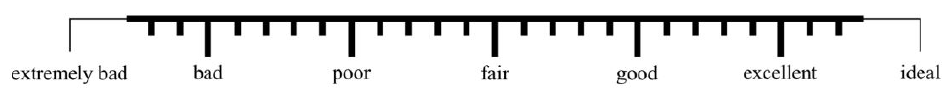
Figure 5. 7-point Absolute Category Rating (ACR) scale [24].